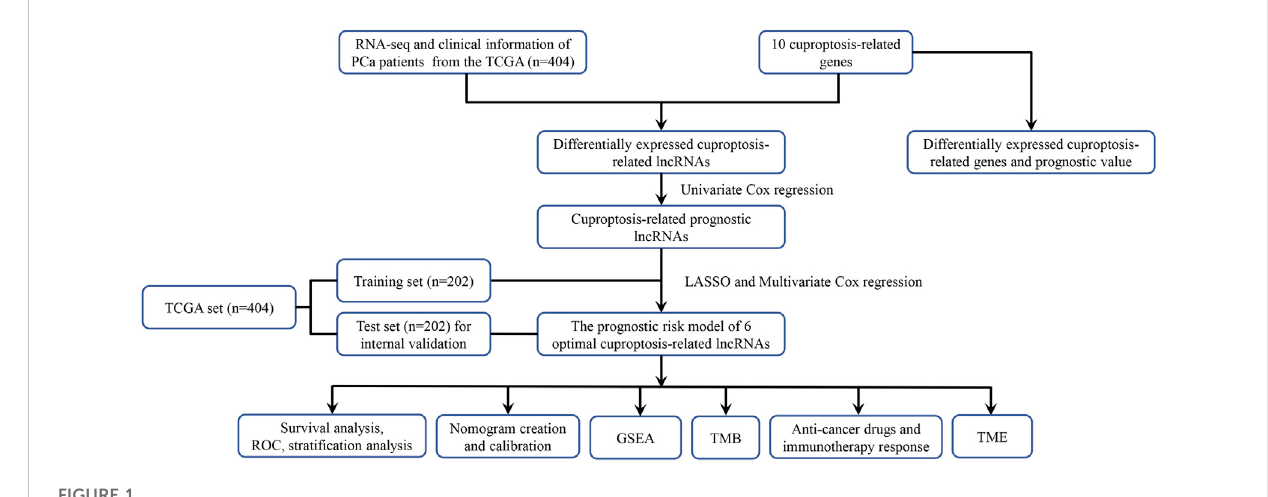
FIGURE 1 The fl owchart of this